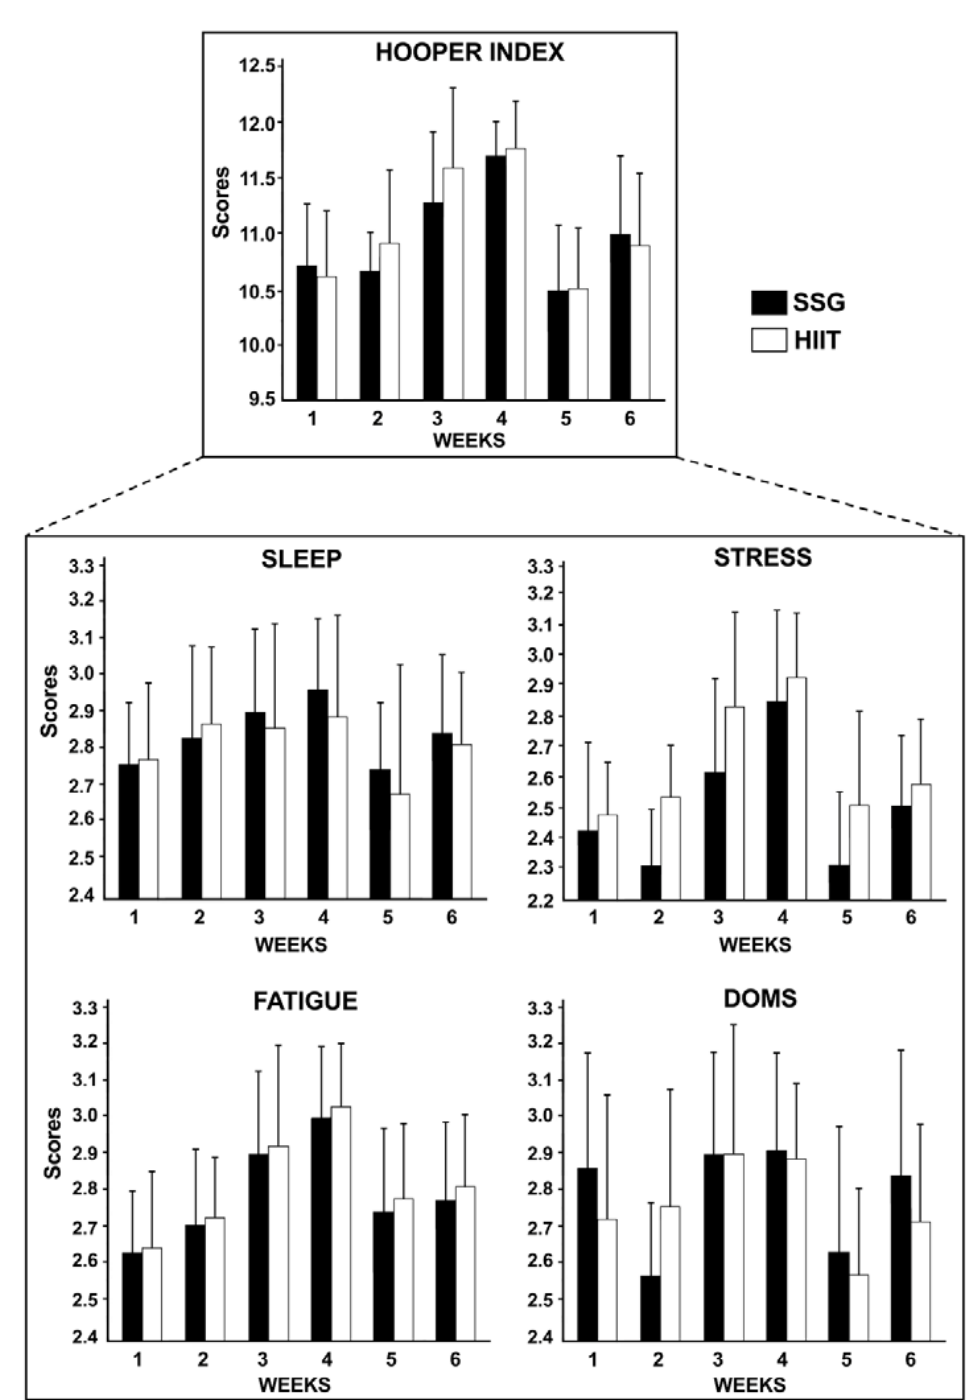
Figure 2. Hooper index which includes four subjective assessments: sleep, stress, delayed-onset muscle soreness (DOMS), and fatigue, measured during all the weeks of high intensity interval (HIIT) or small-sided games (SSG) training.